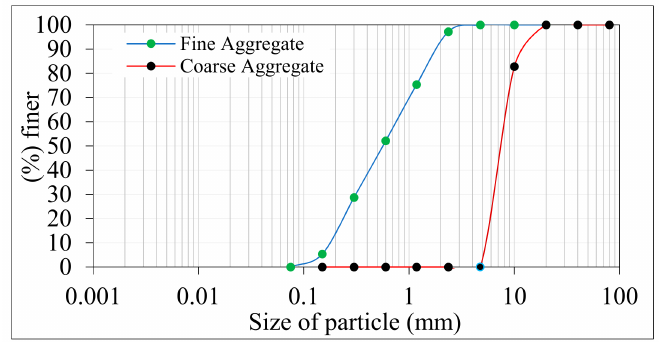
Figure 2. Gradiometric curve for the used aggregates.